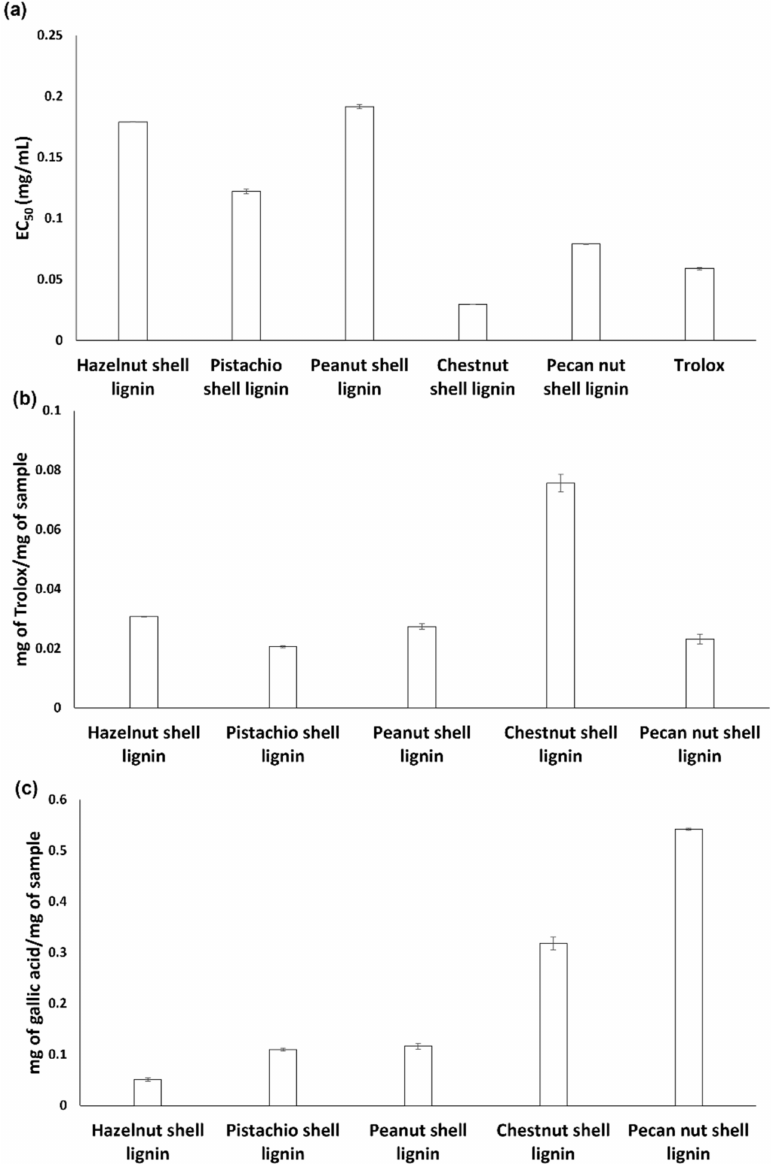
Figure 4. Antioxidant properties and TPC of nut shell-derived lignins. ( a ) DPPH assay; ( b ) FRAP assay; ( c ) Folin-Ciocalteu assay. Reported are the mean ± SD values from at least three